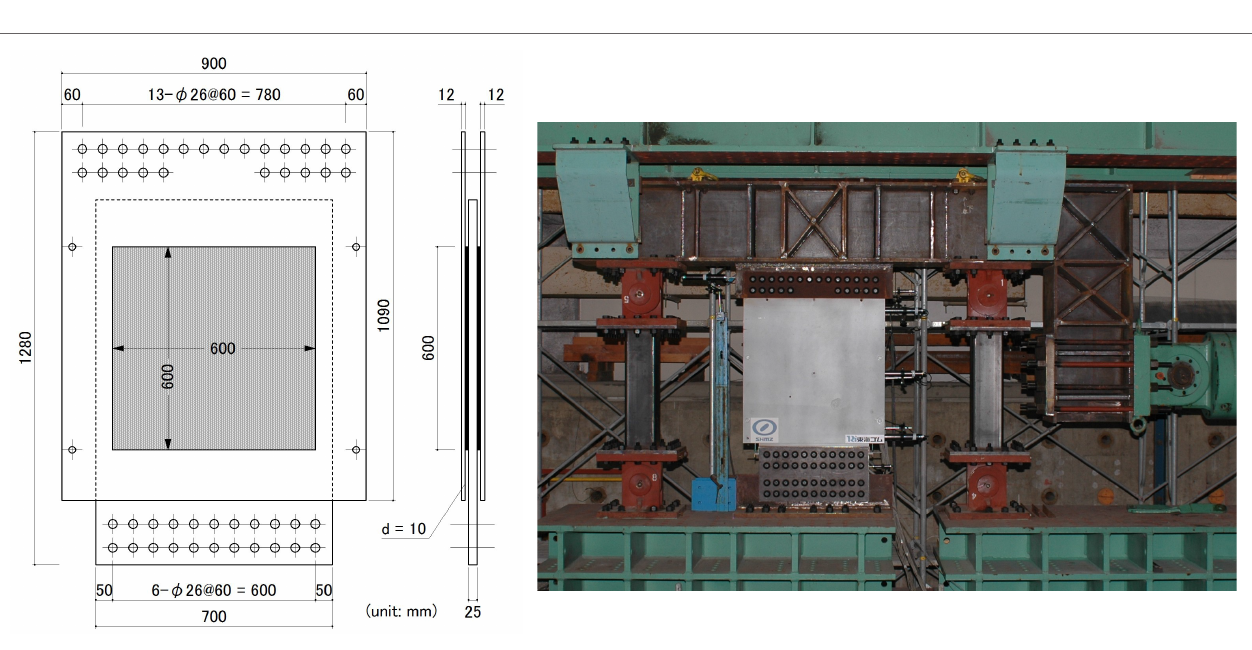
( A s = 5.6 (cid:2) 10 3 mm 2 , d = 5 mm) in Figure 3 for an earthquake interstory drift of the 8th floor of a hypothetical 15-story building (Appendix A). The vertical axis of Figure 11 represents the shear stress, τ which is obtained from the resisting shear force, Q , divided by A s . The horizontal axis of Figure 11 represents the shear strain, γ , which is obtained from the applied time–history deformation, δ , divided by the thickness of the VE material, d